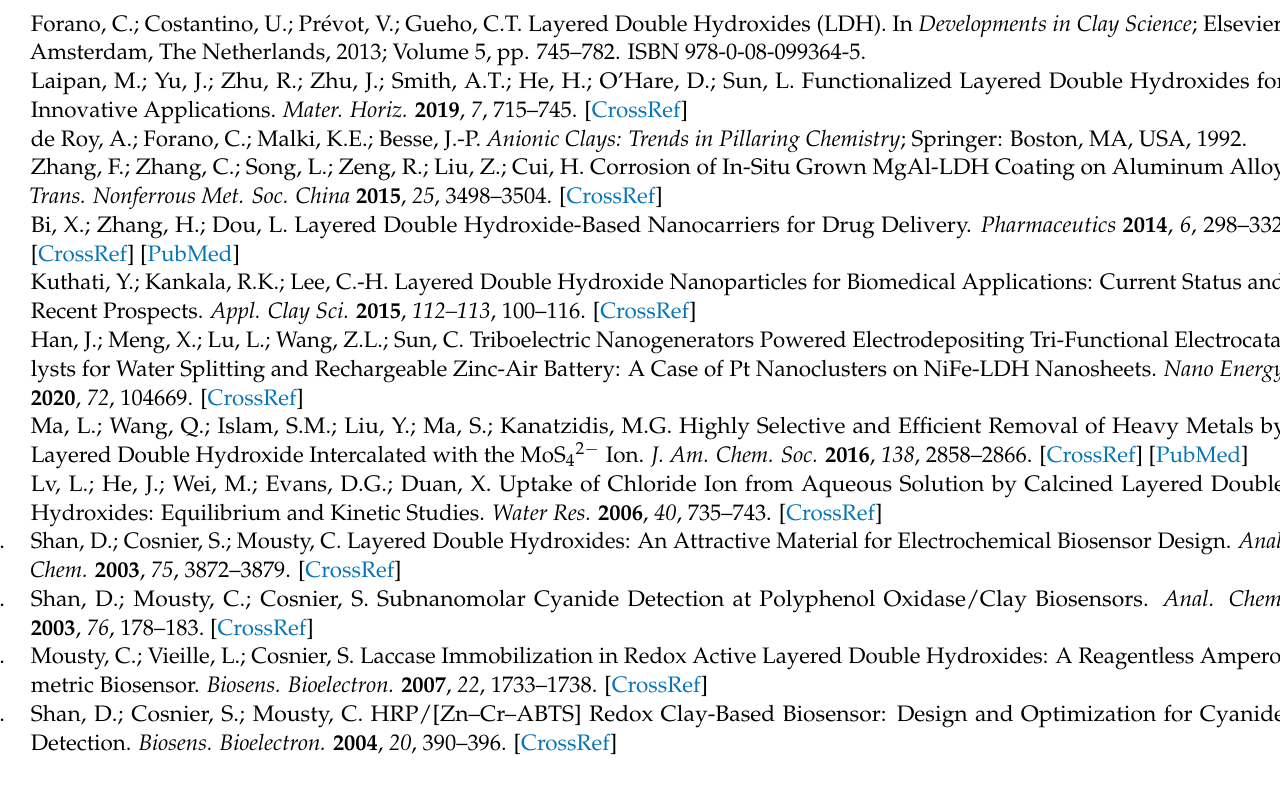
Figure S2: SEM images showing the top surface morphology of (a) LDH as grown, wet with phosphate buffer and dried, (b) LDH + catalase enzyme, wet with phosphate buffer and dried. Scale bar 2 µ m. Figure S3: Clark-type LDH-catalase enzyme biosensor. Linearity ranges and confidence intervals as a function of lifetime: (a) 1st day, (b) 2nd day, (c) 7th day, (d) 14th day, (e) 19th day, and (f) blank.